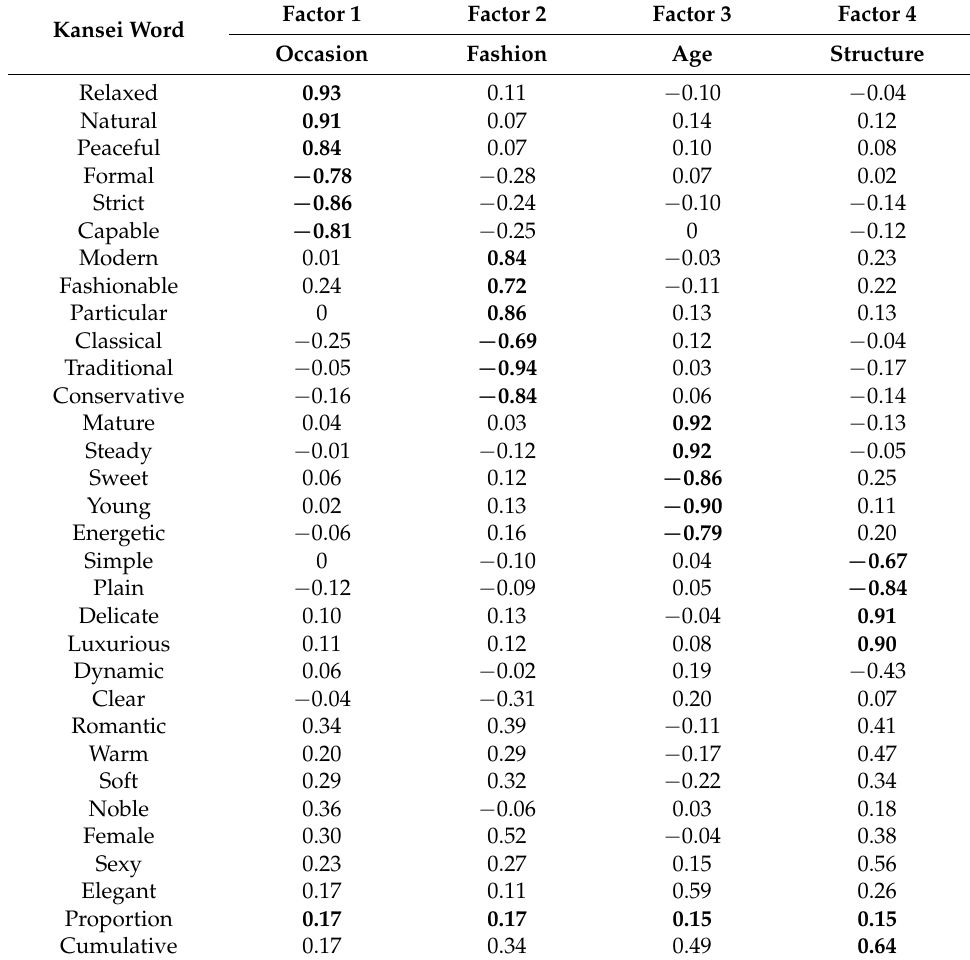
Table 1. Factor loadings of 30 Kansei words using four factors. Factor 1 Factor Kansei Word